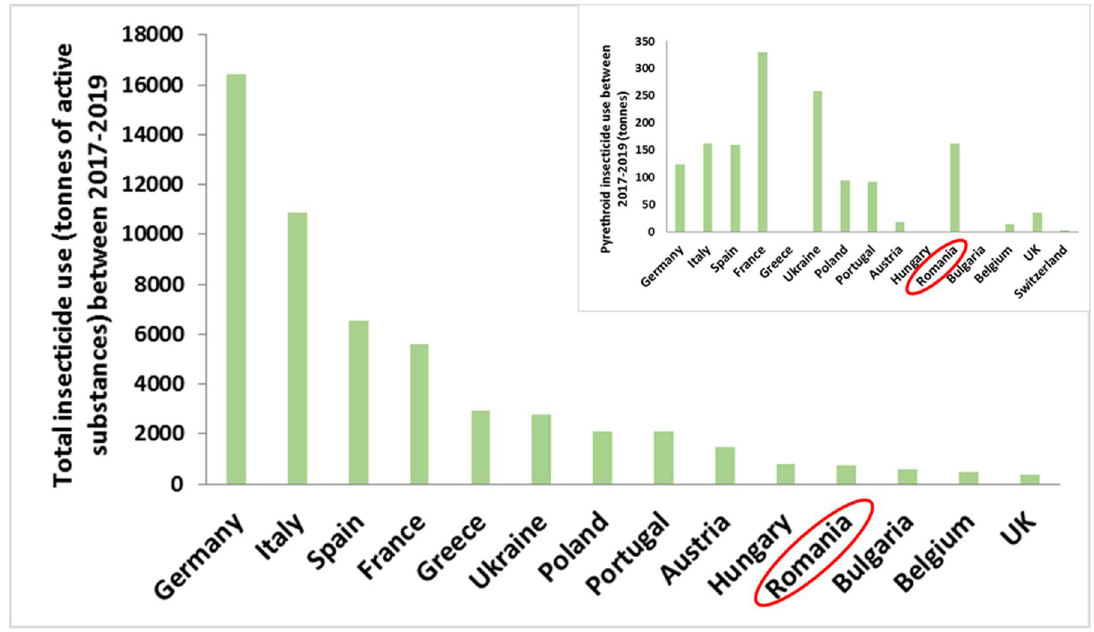
Figure 6. The European countries that used the most insecticides (total insecticide use in tonnes), between 2017 and 2019. The smaller right-sided graphic describes exclusively the pyrethroid use in these countries (the presented graphics are based on data obtained from FAOSTAT database [102]).